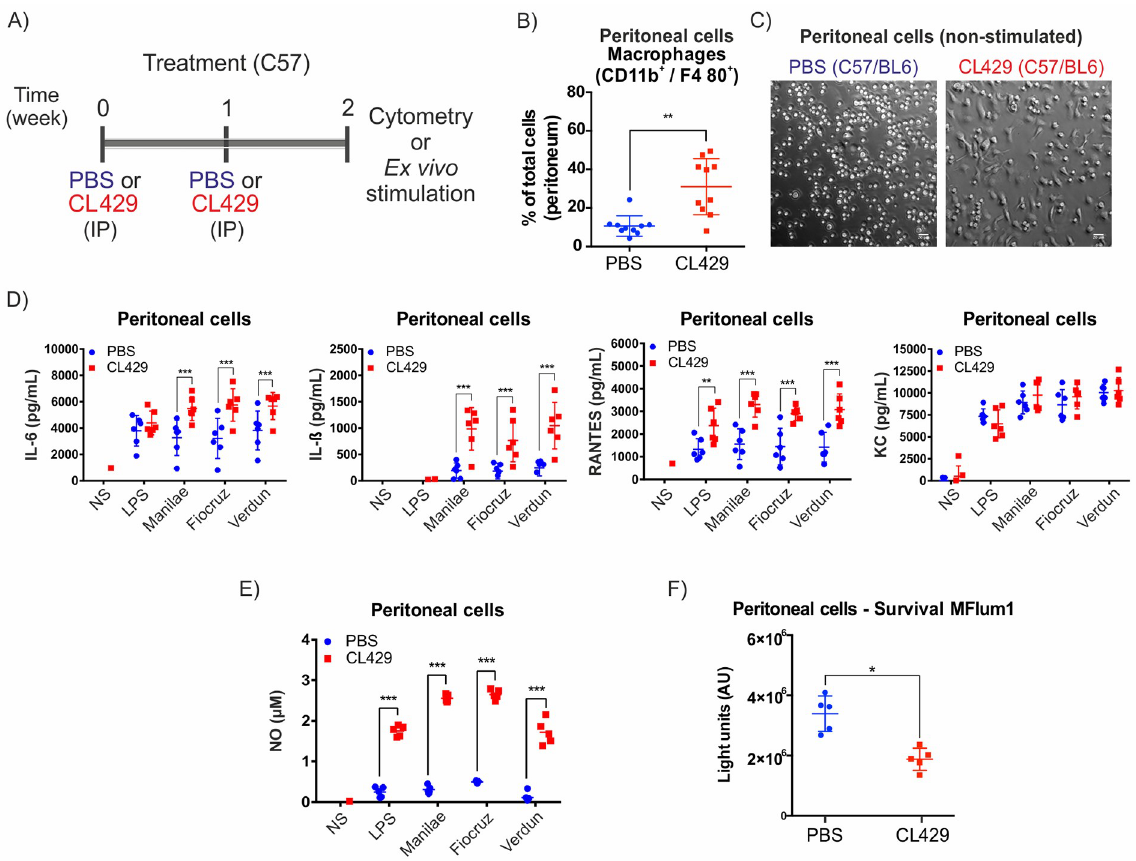
Fig 3. Treatment with CL429 enhances ex vivo antibacterial responses. A) Chronogram of the experiment. C57BL/6 WT mice were injected IP with 200 μ L PBS containing 2.5% DMSO (vehicle) or 25 μ g CL429 2 and 1 weeks before the collection of peritoneal cells for cytometry or ex vivo stimulation. Cells were plated, and adherent cells were exposed for 24 h to 100 ng/mL E . coli LPS or live Leptospira interrogans serovar Manilae, Fiocruz or Verdun at a MOI of 100. B) Flow cytometry analysis showing the percentage of macrophages (CD11b + /F4/80 + ) recovered in peritoneal lavages from treated (CL429) or control (PBS) mice. The plot corresponds to 2 independent experiments pooled with n = 5 mice in each group. C) Representative phase contrast microscopy image of adherent peritoneal cells seeded in 96-well plates at 3 h post-collection (non stimulated (NS) cells). D) Pro-inflammatory cytokine (IL-6, IL-1 β ) and chemokine (RANTES, KC) production determined by ELISA 24 h post- stimulation in the supernatant of peritoneal cells. Data are representative of 4 independent experiments (n = 4 to 6 mice per group, treated individually). E) Nitric oxide (NO) production in peritoneal cells 24 h after stimulation assessed by the Griess reaction. Data are representative of 4 independent experiments (n = 4 to 6 mice per group, treated individually). F) Peritoneal macrophages were exposed to bioluminescent L